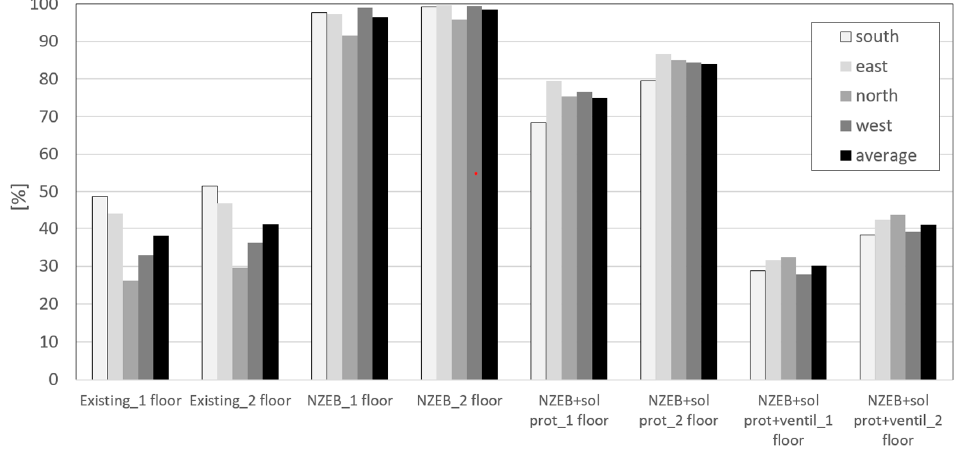
Figure 6. Relative discomfort hours of the different building configurations in Rome.